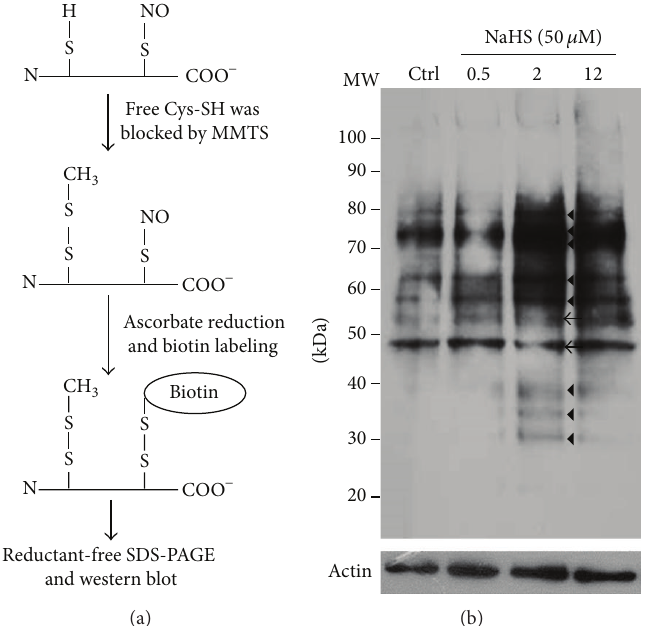
Figure 4: Detection of protein S-nitrosylation. (a) Scheme representing the procedures of modified biotin switch. Biotin-labeled lysates were subjected to SDS-PAGE without any reducing agents in the buffers. (b) ECs lysate (100 𝜇 g) treated with NaHS (50 𝜇 M) for 0.5, 2, and 12h separated by SDS-PAGE and the blotted membranes were hybridized with streptavidin-HRP. Triangle indicates proteins with increased S-nitrosylation. Arrow head indicates proteins with decreased